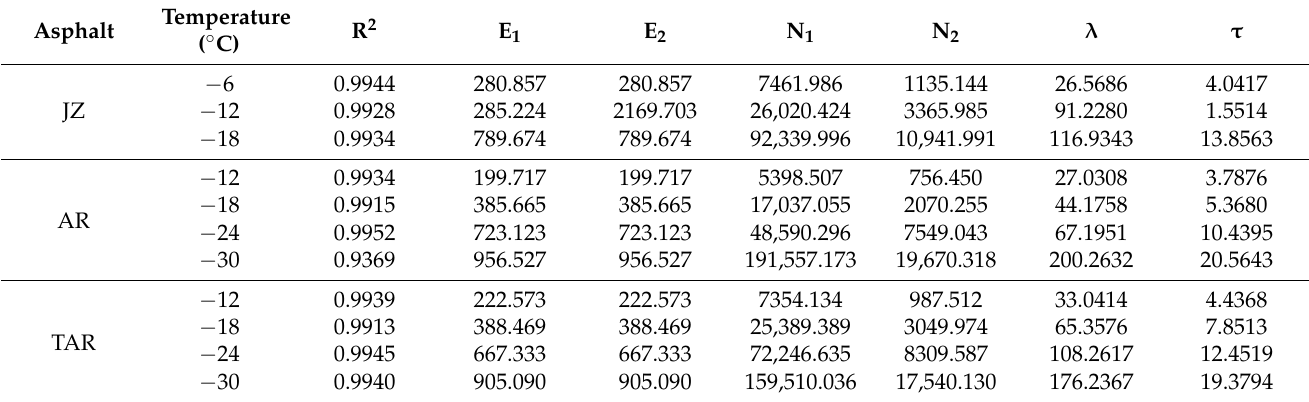
Table 13. Burgers model parameter results at different temperatures.